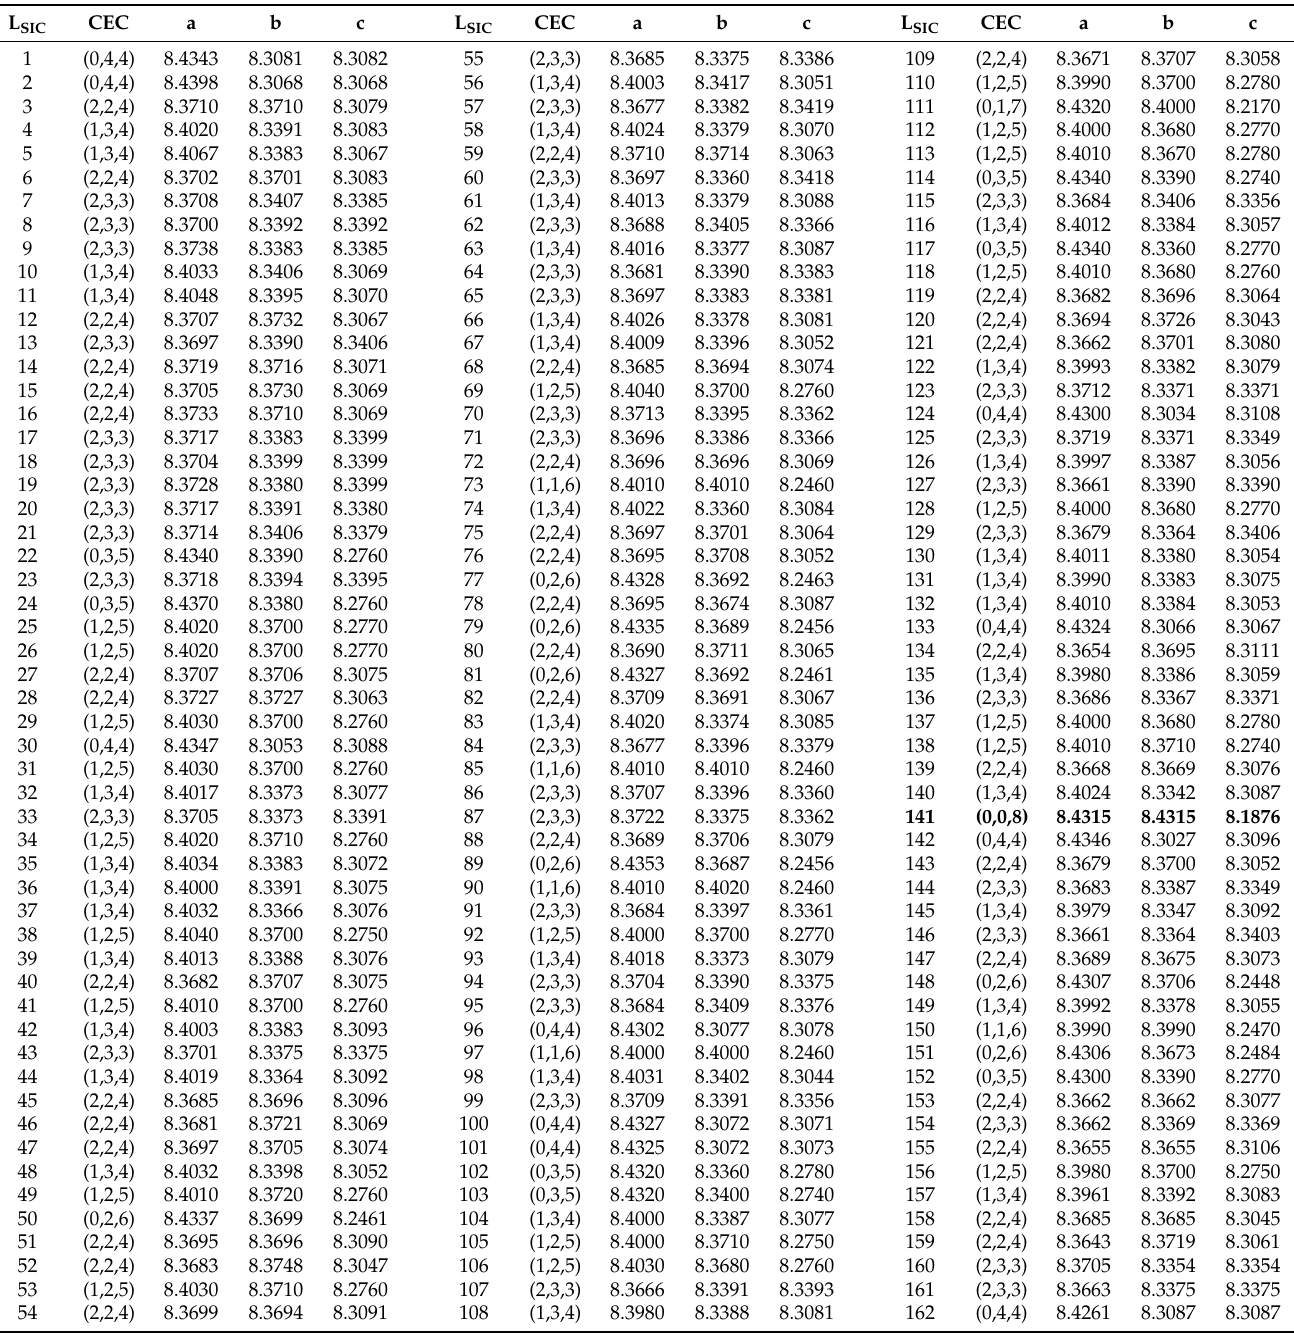
Table A5. B3LYP set of optimized S222 cell parameters per SIC. As in Table A3, SICs are ordered by increasing energy and labelled (L SIC ). In a given SIC, the parameters can permute depending on the considered